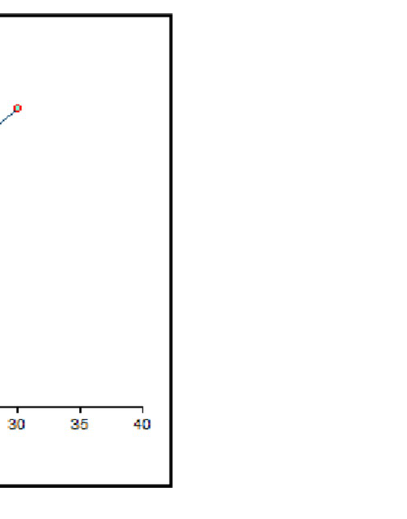
Fig 14. Signaling cost vs. the number of